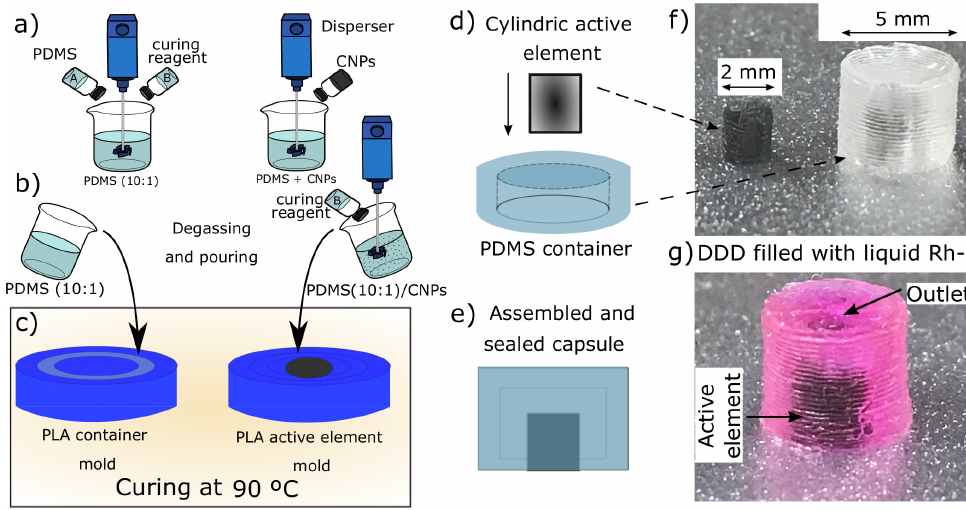
Figure 2. Drug delivery device based on polydimethylsiloxane nanocomposites: ( a ) synthesis of the PDMS/CNPs nanocomposites; ( b ) degassing and pouring of the polymers within the poly(lactic acid) PLA molds; ( c ) curing process to obtain the containers and the active elements; ( d ) assembling of the containers and active elements; ( e ) assembled and sealed capsule ready to be filled with Rh-B; ( f ) image of a real active element and PDMS container; and ( g ) image of a real DDD filled with